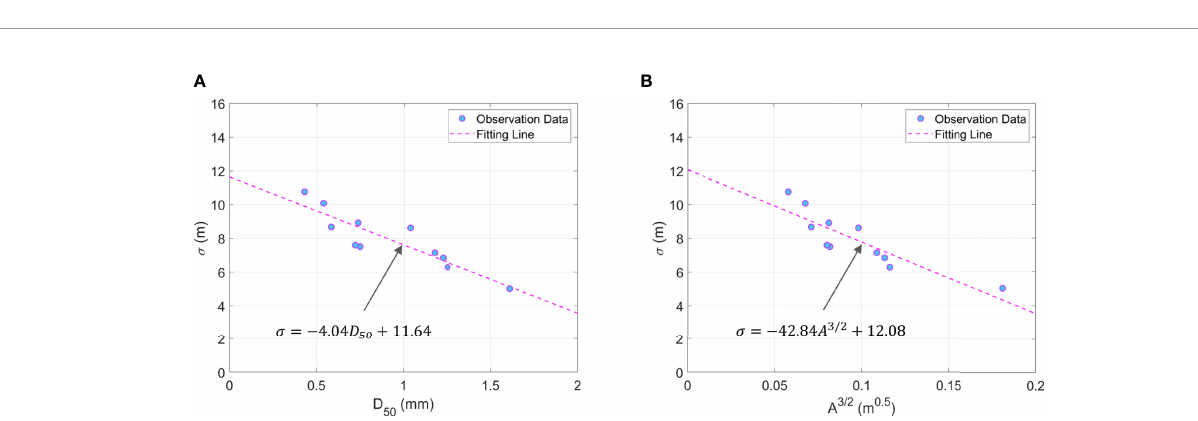
FIGURE 5 | Correlation curve between grain size of sand and standard deviation: (A) median grain size D 50; ( B) beach scale factor A .